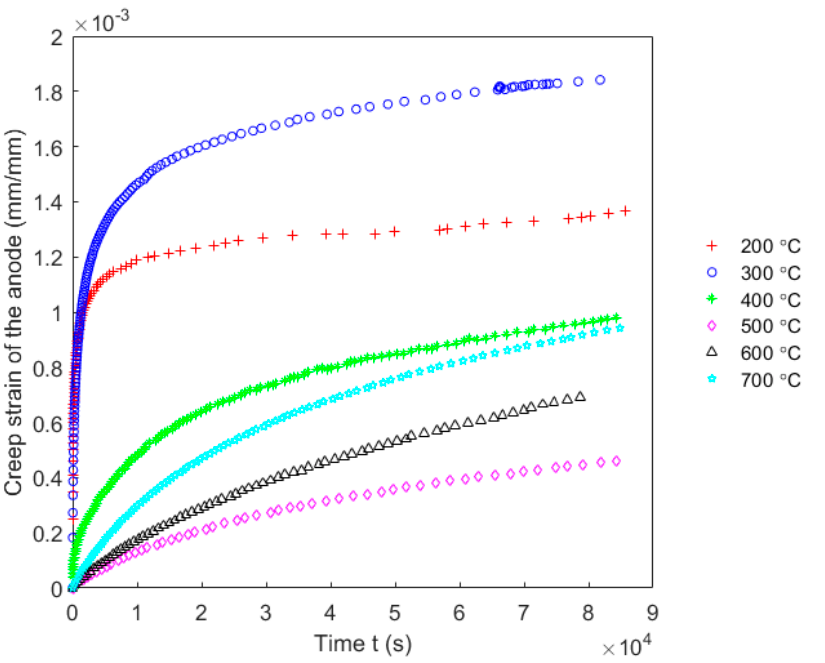
Figure 17. Creep strains of the carbon anode in the axial direction at different baking temperatures ranging from 200 to 700 °C.